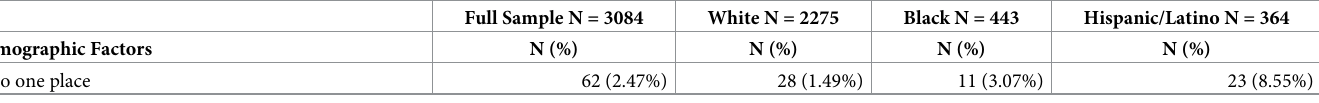
In Table 1, The CES-D refers to the Center for Epidemiological Studies Depression (CES-D) Scale (a), while chronic conditions included hypertension, diabetes, cancer, chronic lung disease, heart conditions, stroke, psychiatric problems, and arthritis (b). Also, participants were asked if they had difficulty with any of five activities: bathing, dressing, eating, walking, and getting out of bed (c).